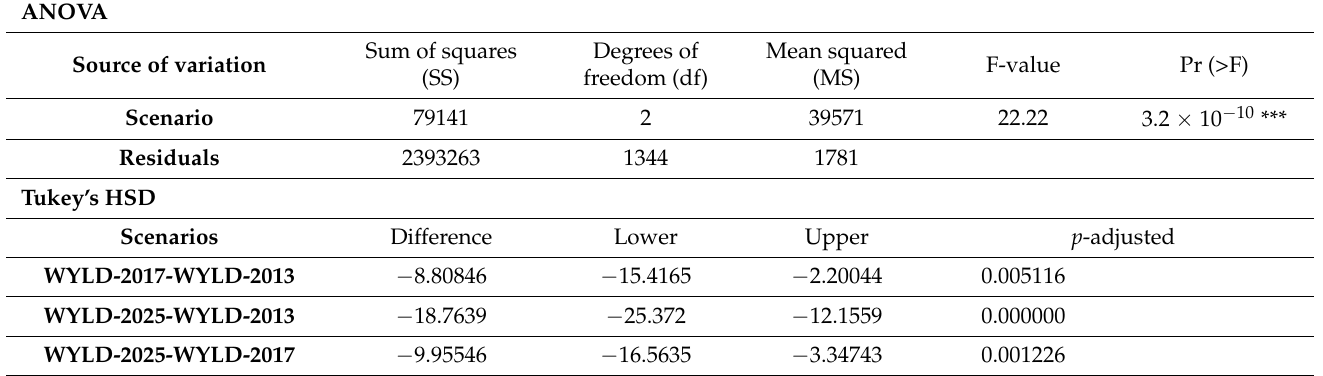
Table 4. Analysis of variance (ANOVA) test and Tukey’s honestly significant difference (Tukey’s HSD) post hoc test for pairwise comparisons of the water yield under different